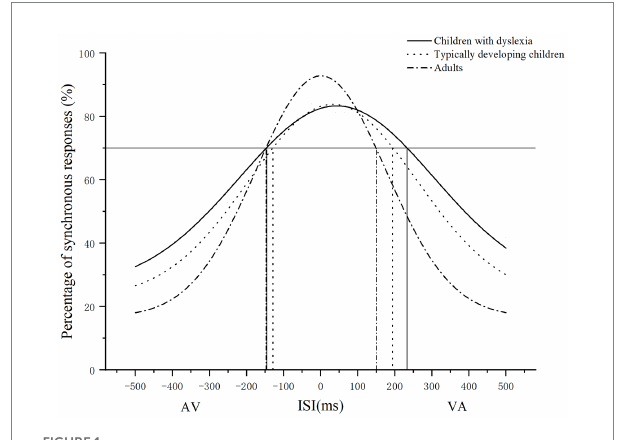
FIGURE 1 Examples of Gaussian curves fitting the data of three participants in different groups. The ISI value corresponding to the intersection of the horizontal line and the Gaussian curve is the size of the AV (the width between the left vertical line and 0 ms) and VA TBW (the width between 0 ms and right vertical line) when the percentage of synchronous responses is